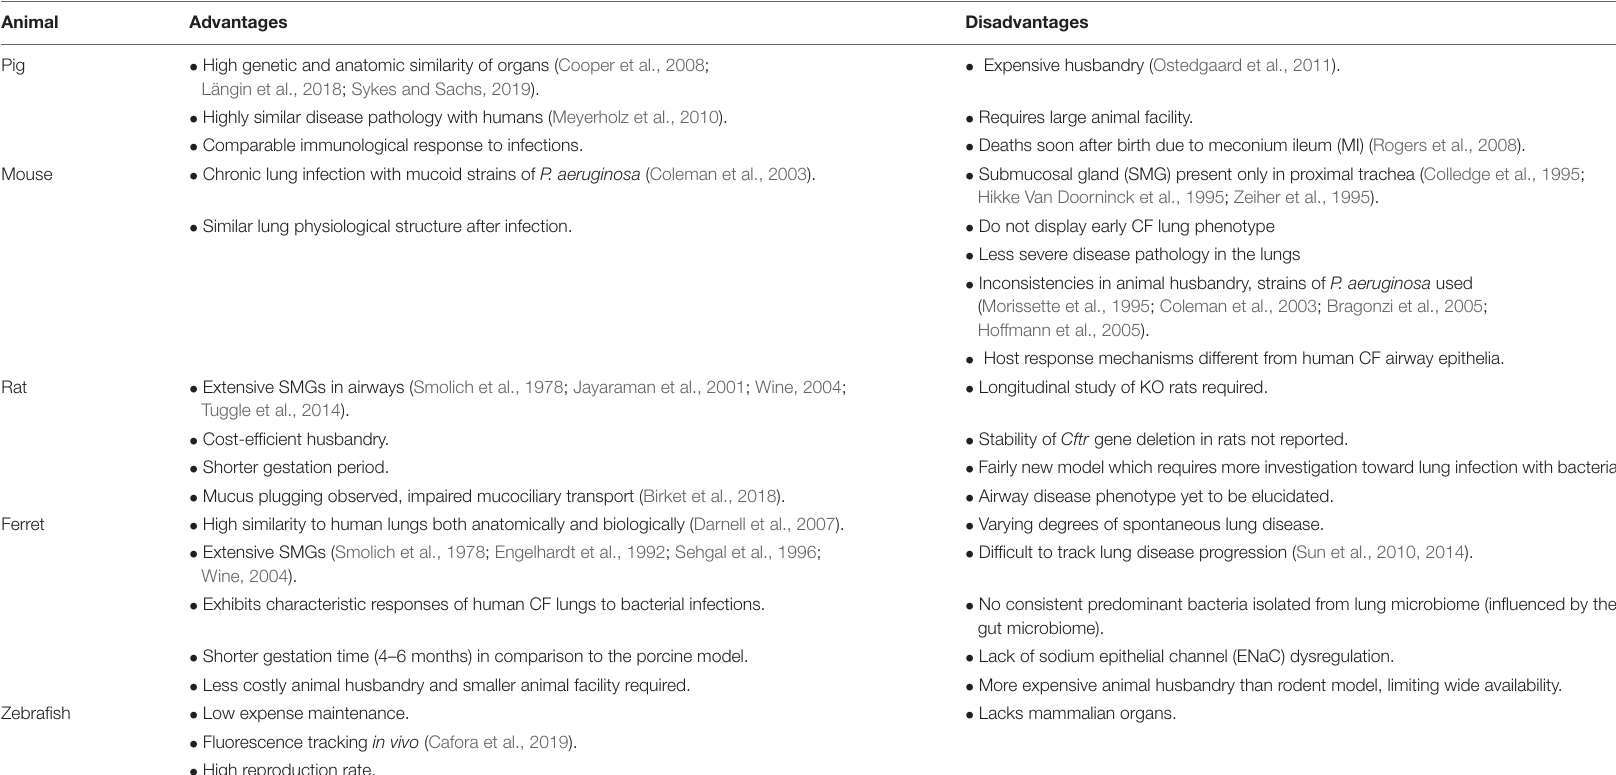
TABLE 1 | Comparison of available CF animal models. Animal Advantages Disadvantages